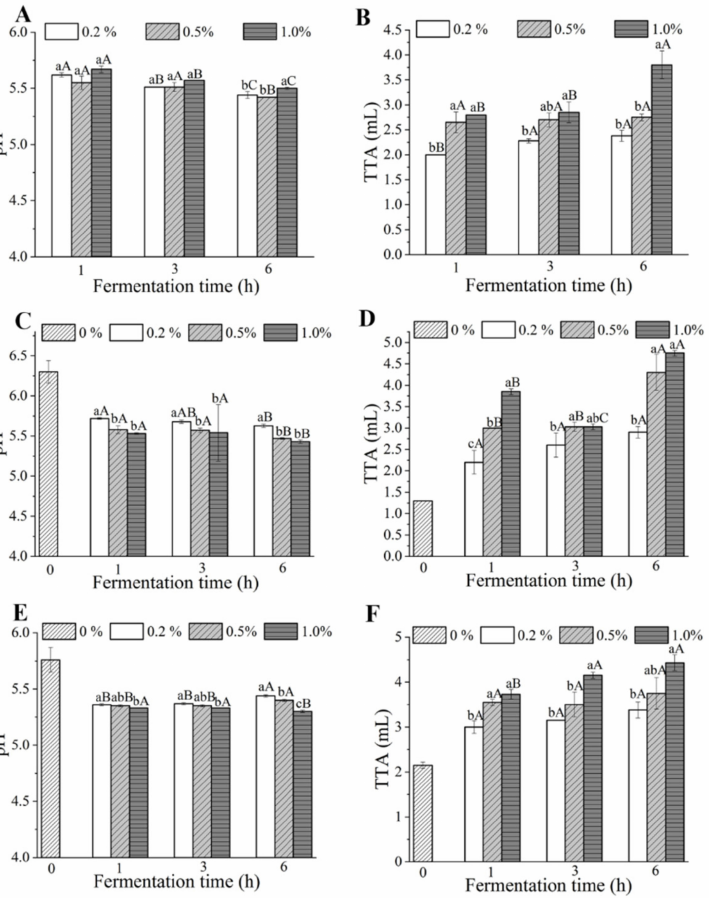
Figure 1. Effect of fermentation time and amount of yeast added on the pH and TTA of bat- ter ( A , B ), noodle dough ( C , D ) and dried noodle ( E , F ) samples. TTA, total titratable acidity. Different lowercase letters indicate that the data related to different yeast additions are signifi- cantly different under the same fermentation time. Different capital letters indicate that the data related to different fermentation times are significantly different under the same yeast